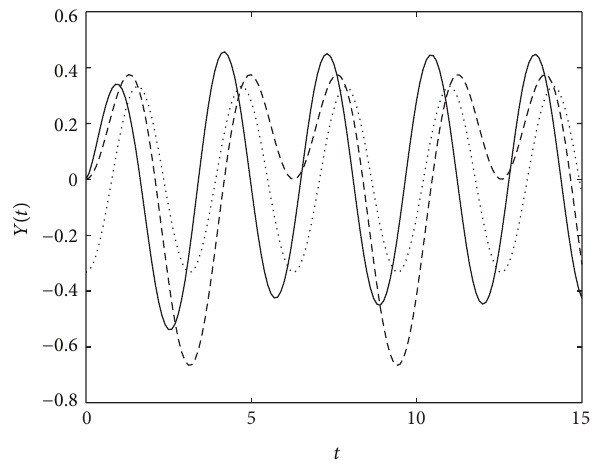
Figure 1: Solid line: 𝑌(𝑡) versus 𝑡 on interval 0 ≤ 𝑡 ≤ 15 for 𝑐 = 1, 𝜆 = 2 , and 𝛼 = 1.5 ; dashed line: ( cos (2𝑡) − cos (𝑡))/− 3 versus 𝑡 ; doted line: cos (2𝑡)/− 3 versus 𝑡 .